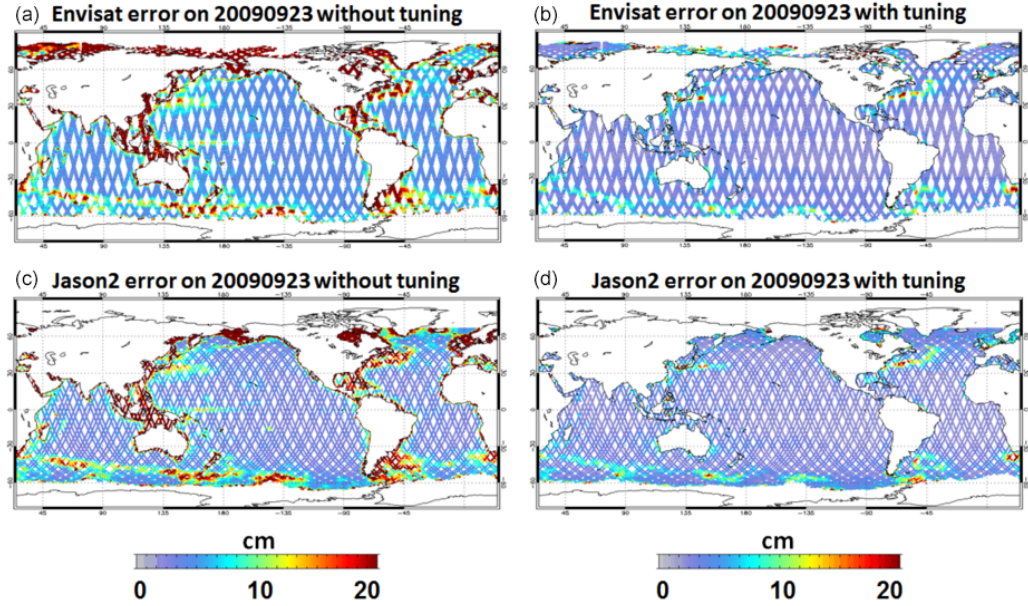
Figure 17. Envisat (a, b) and Jason2 (c, d) satellite observation errors used on the 7-day assimilation cycle ending 23 September 2009 without tuning (a, c) and with the tuning (b, d) method. Unit is centimeters.